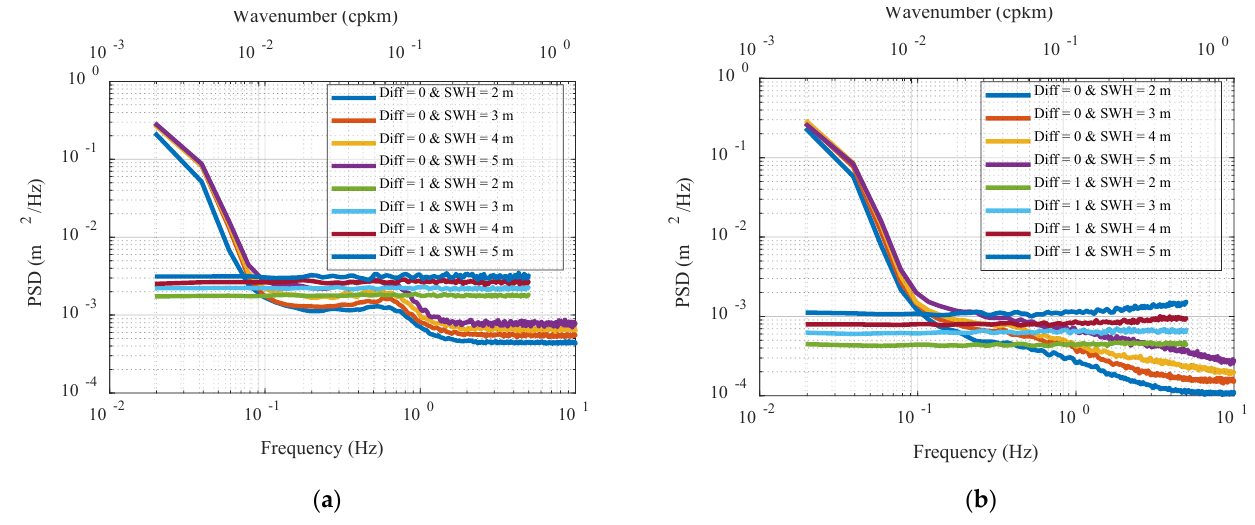
Figure 10. The average PSD with the SWH of 2–5 m in ( a ) LR mode and ( b ) HR mode. In each figure, Diff = 0 represents the PSD result of the nondifferential method, and Diff = 1 represents the PSD result of the differential method. The vertical axis is the power spectrum density, the bottom horizontal axis is the signal frequency, and the top horizontal axis is the wavenumber.